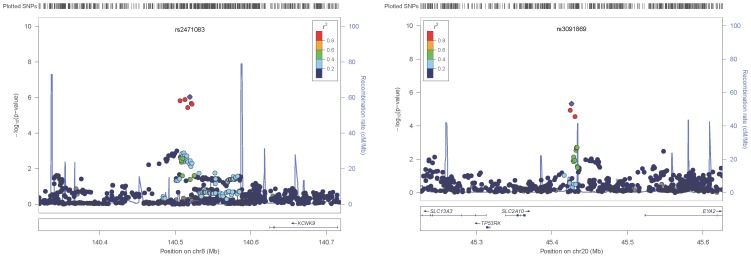
Local association plots.Panels show the local POE association P-values for the KCNK9 (left panel) and SLC2A10 (right panel) loci.